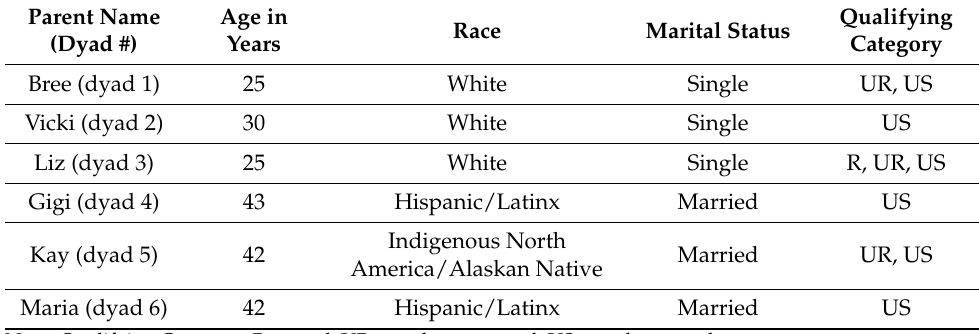
Table 2. Parent Participant